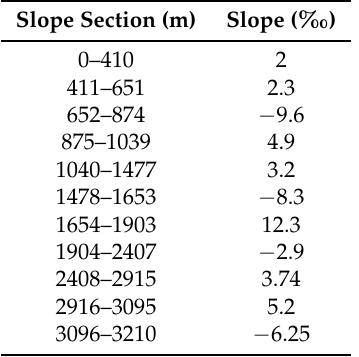
Table 6. The ramp parameters from Dalian North Station to Houyan.